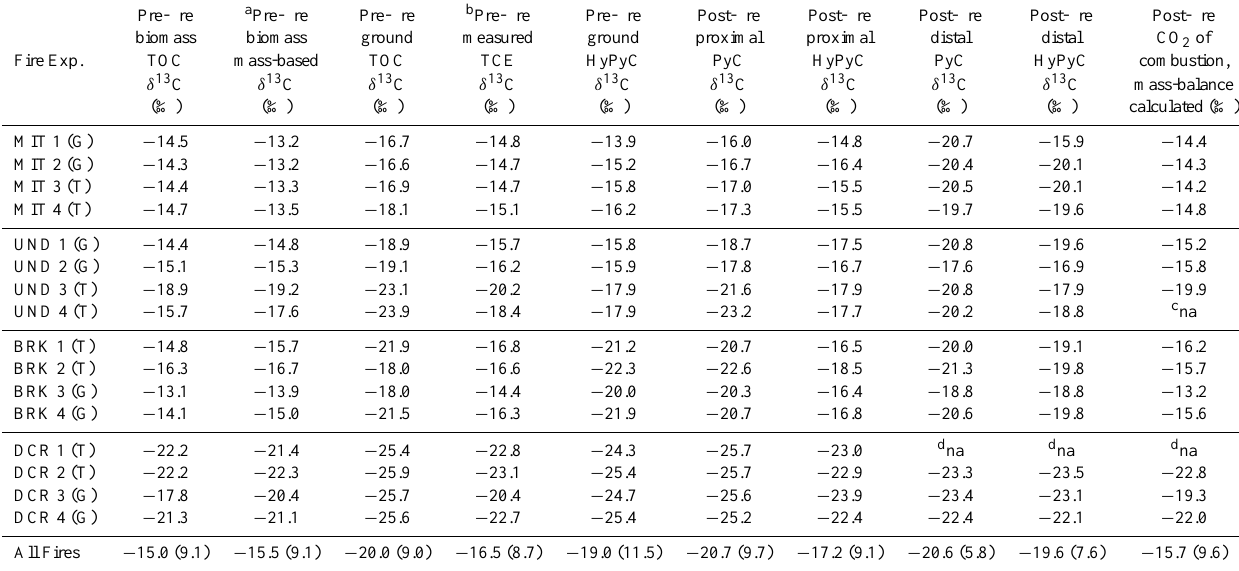
Table 3. Stable isotopic composition ( δ 13 C values) of C fluxes from each of the fires; standard errors of the means are shown in parentheses. Explanations for the different fractions are as in Table